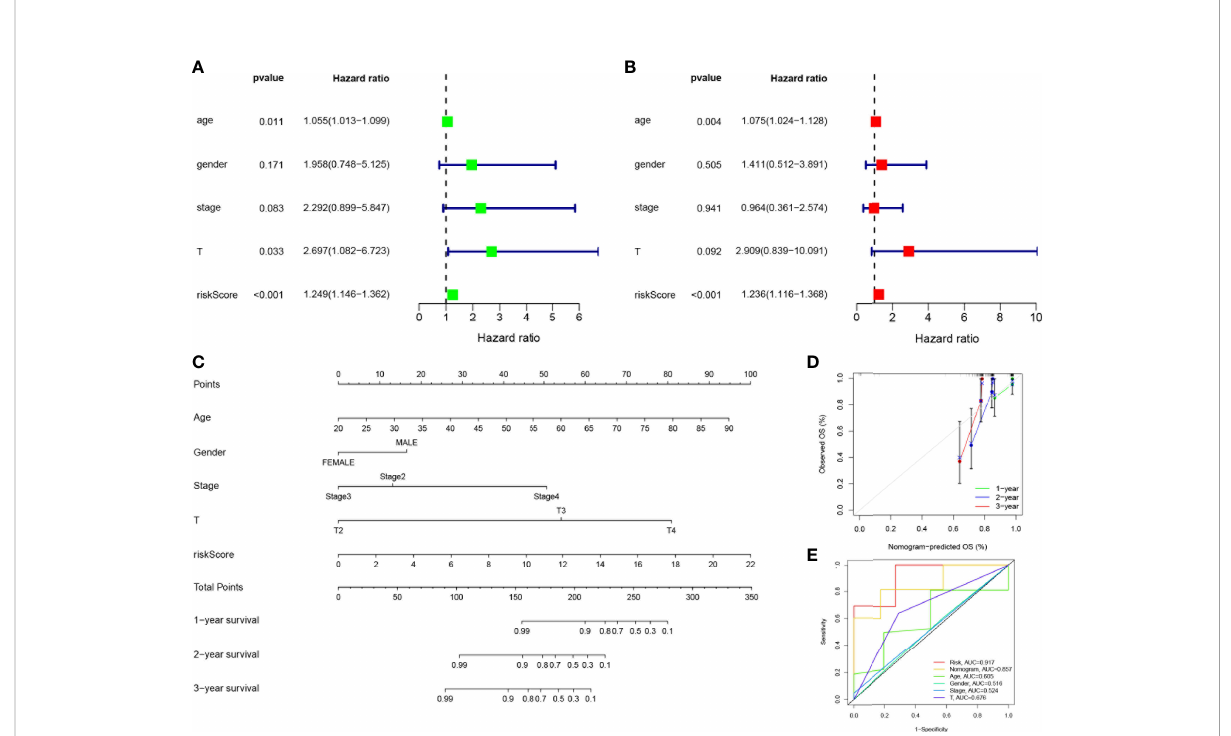
FIGURE 5 Establishment of nomograms in combination with clinical characteristics. (A) Univariate and (B) multivariate COX regression analysis of the signature and different clinical feature. Green squares: univariate cox analysis of HR values for each variable. Red squares: multivariate cox analysis of HR values for each variable. (C) A nomogram combining the SMGs, age, gender, clinical stage, and T stage. (D) The calibration curve of the constructed nomogram of 1-year, 2-year and 3-year survival. (E) The nomogram ’ s time-dependent ROC